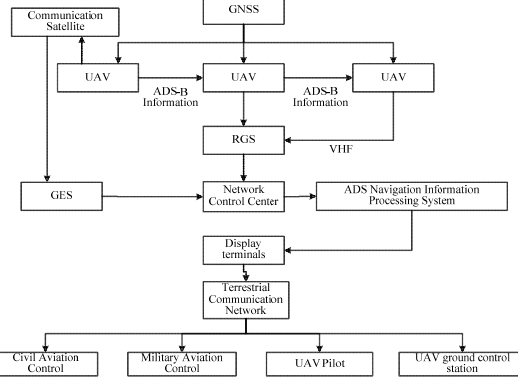
Figure 1. UAV flight conflict awareness scheme.